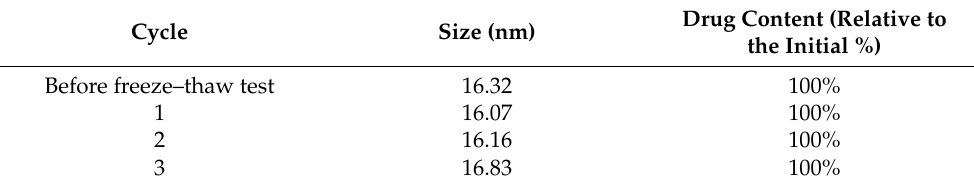
Figure 7. Droplet size change ( a ) and appearance and content change ( b ) under different storage conditions. Table 1. Freeze–thaw experiment results of the DAS nanoemulsion.